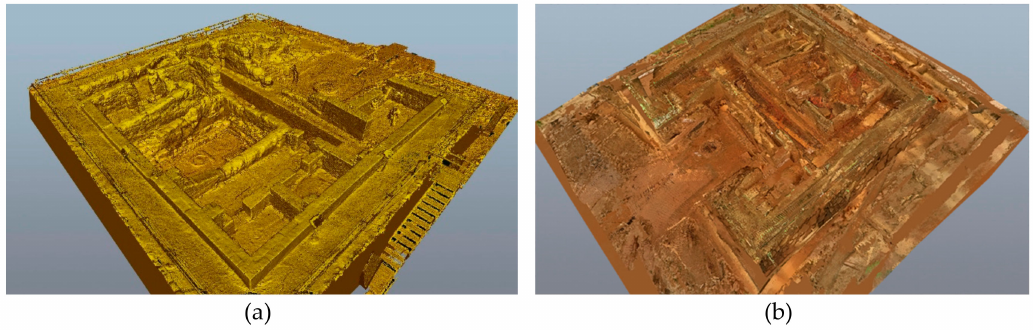
Figure 4. ( a ) 3D mesh of the archaeological site obtained after adaptation; ( b ) resulting